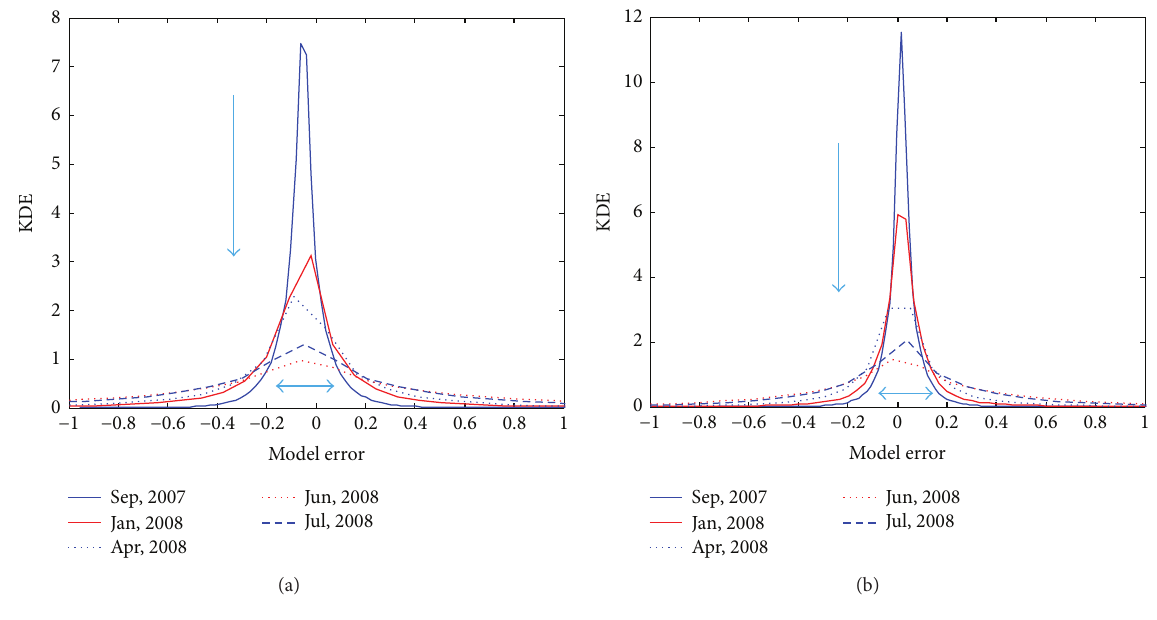
Figure 6: Model error test for the points (a) 1 and (b)